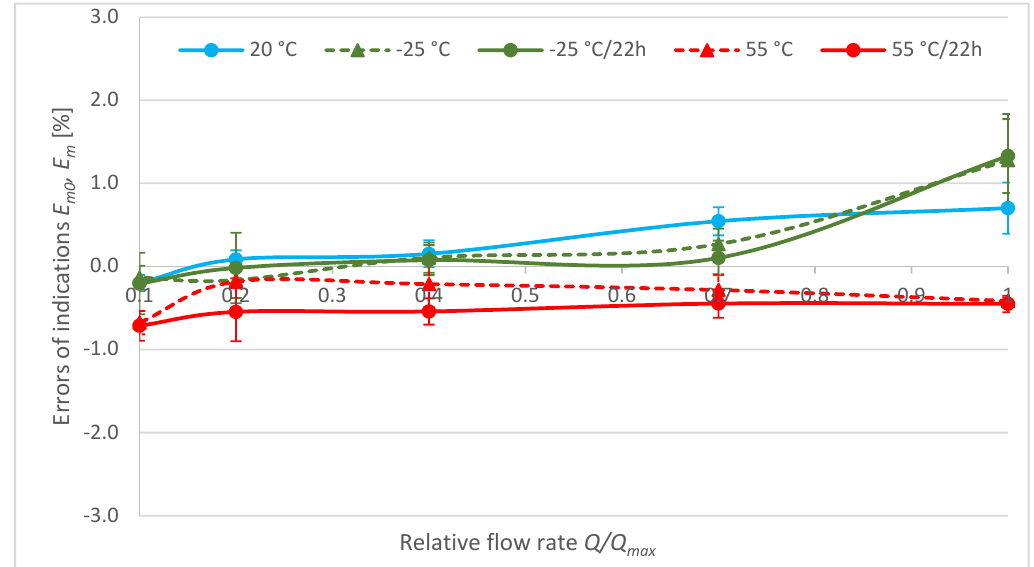
Figure 8. Average drift of the errors of indications ( E m ) together with the confidence interval ( u ) of thermal gas meters for different gas mixtures as a function of the relative flow rate ( Q/Q max ). Initial errors of indications ( E 0 ), errors of indications ( E ), average initial errors of indications ( E m 0 ) and average errors of indications ( E m ) together with the confidence interval ( u ) of thermal gas meters (serial numbers 42089119, 42089121, 42089125 and 42089126) adjudged at the ambient and gas ◦ ◦ temperature of − 25 C and 55 C, respectively, are shown in Table 4, Figures 8 and 9. The errors of indications were determined with the use of air for individual test variants given in Table 2. of flow rates from 0.1 Q max to Q max .